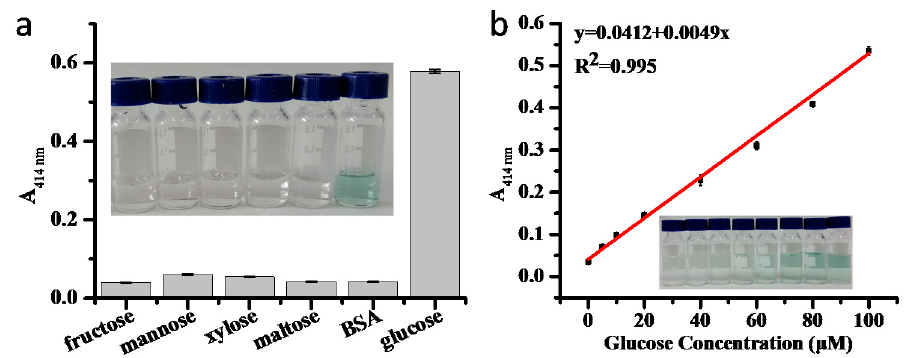
Figure 5. ( a ) The selectivity of the GOx–HRP–Zn/adenine complexes for 100 μ M glucose in comparison to 100 μ M fructose, mannose, xylose, maltose and 1 mg/mL bovine serum albumin (BSA) (inset: photographs of the samples.); ( b ) detection of glucose in solutions with glucose concentrations of 0–100 μ M (absorbance at 414 nm was measured after incubation in solution for 10 min at room temperature) (inset: photographs of the samples).